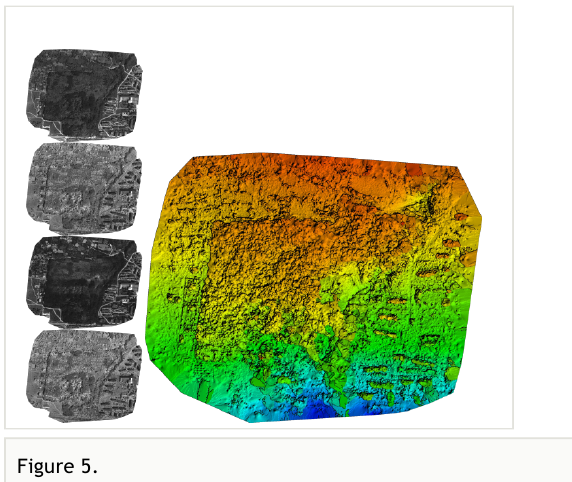
Figure 5. Digital Surface Model of ‘Apostolova gora’ park.